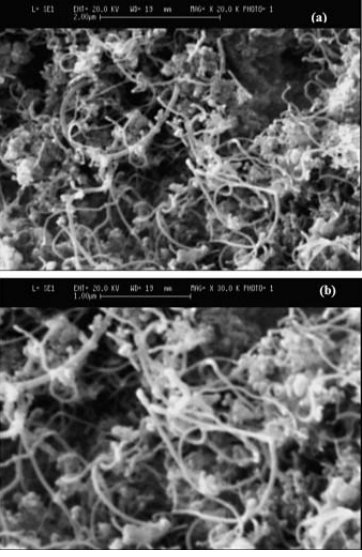
Figure 3. SEM image of the spent 10 wt % Co/MgO catalyst after 15 h reaction at 700 °C. Reproduced with permission from [44]. ( a ) Low magnification; ( b ) high magnification. Table 2. Co-based catalysts and noble metal catalysts for DRM.